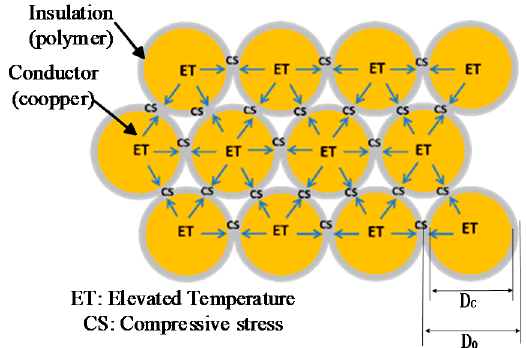
Figure 4. Cross-sectional view of a multilayer winding.